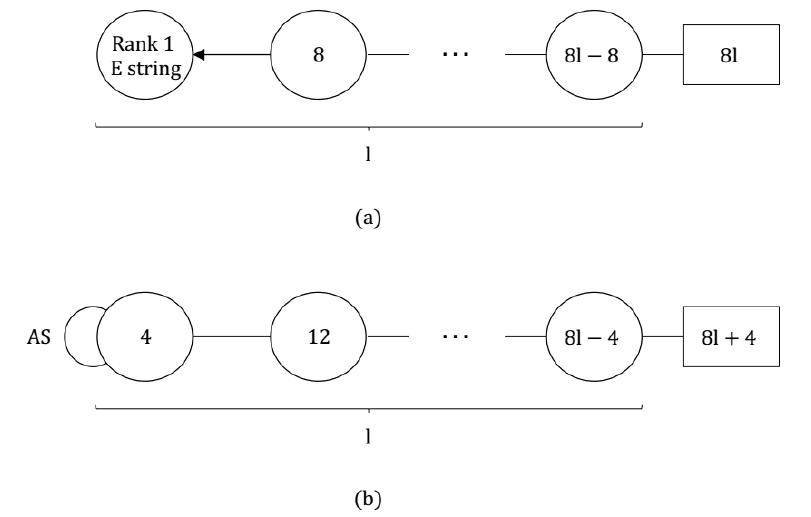
Figure 7 . Quivers of 6 d gauge theories which are the low-energy tensor branch descriptions of certain 6 d SCFTs. Here all groups are of type su .